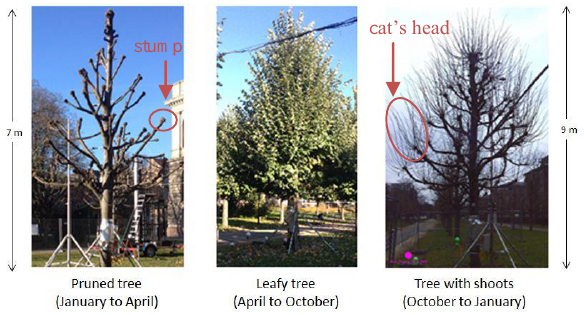
Figure 3. Illustration of the three phenological stages of a silver lime